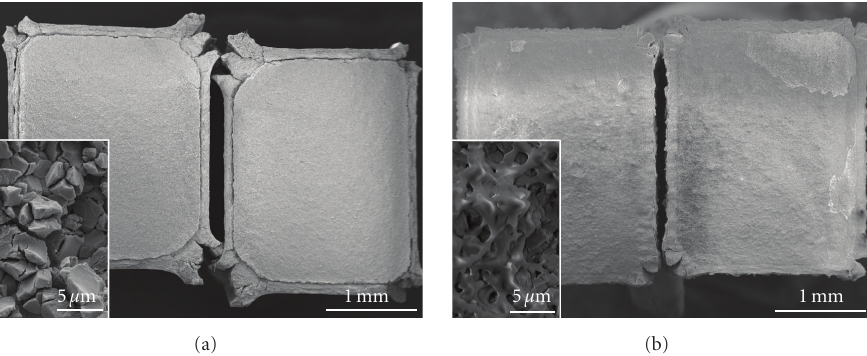
Figure 10: Fracture analysis after bending tests of HfC-based composites at 1500 ◦ C in Ar. Appearance of the bars and, in the insets, fracture surface of (a) HC5 and (b)